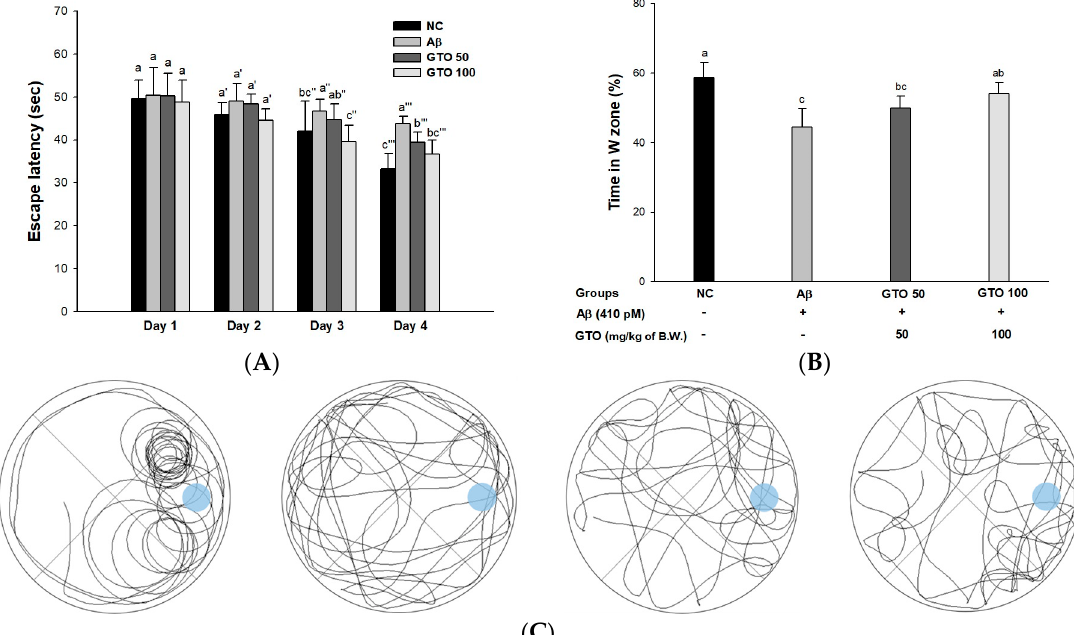
Figure 5. Protective effect of green tea seed oil (GOT) on Morris water maze test in A β -induced mice. ( A ) Escape latency in the training trial; ( B ) retention time on W zone in the probe trial ( C ) path tracing of each groups in the probe trial. Results shown are mean ± SD ( n = 8). Data were statistically represented at p < 0.05, and different lowercase letters indicate statistical significance. NC: A β - /sample - group; A β : A β + /sample − group; GTO 50: A β + /GTO (50 mg/kg of body weight) + group; GTO 100: A β + /GTO (100 mg/kg of body weight) + group. B.W.: body weight.